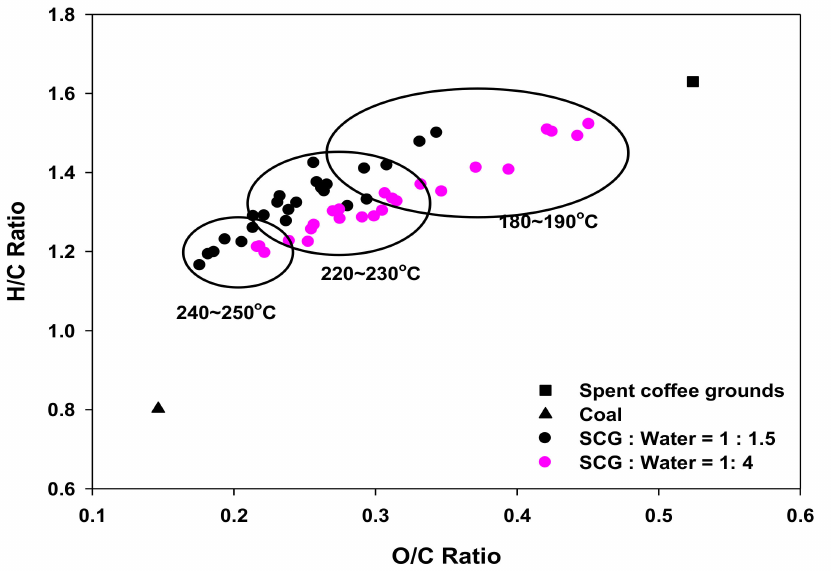
Figure 8. Van Krevelen diagram of raw material, coal, and hydrothermally carbonized SCGs pro- duced with different reaction temperatures and water